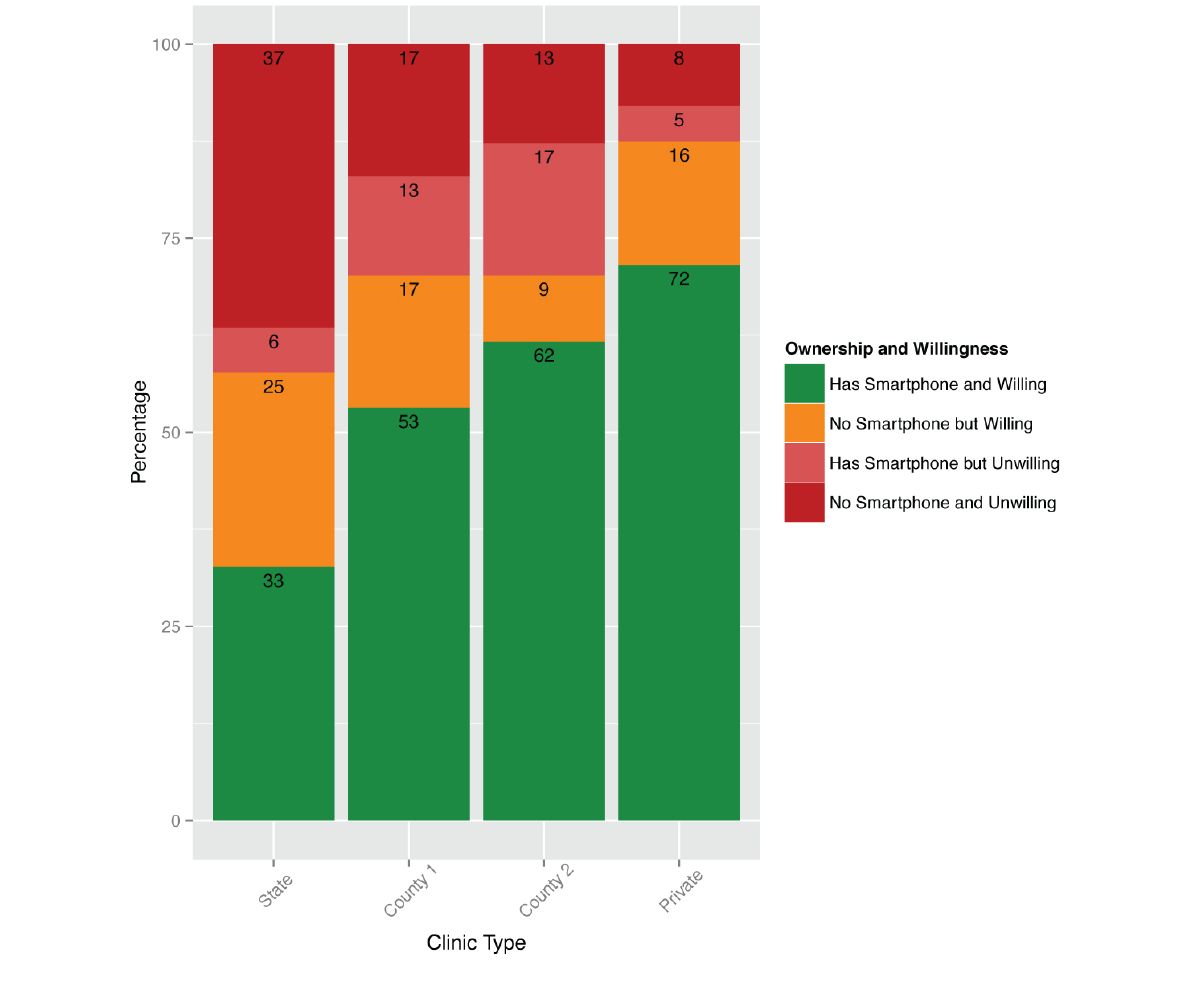
Figure 1. Percent ownership of smartphones (question 7) and interest in using a smartphone to monitor mental health conditions (question 16) by